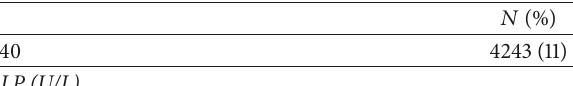
Table 1: Demographic characteristics and lipid and liver enzyme laboratory data.